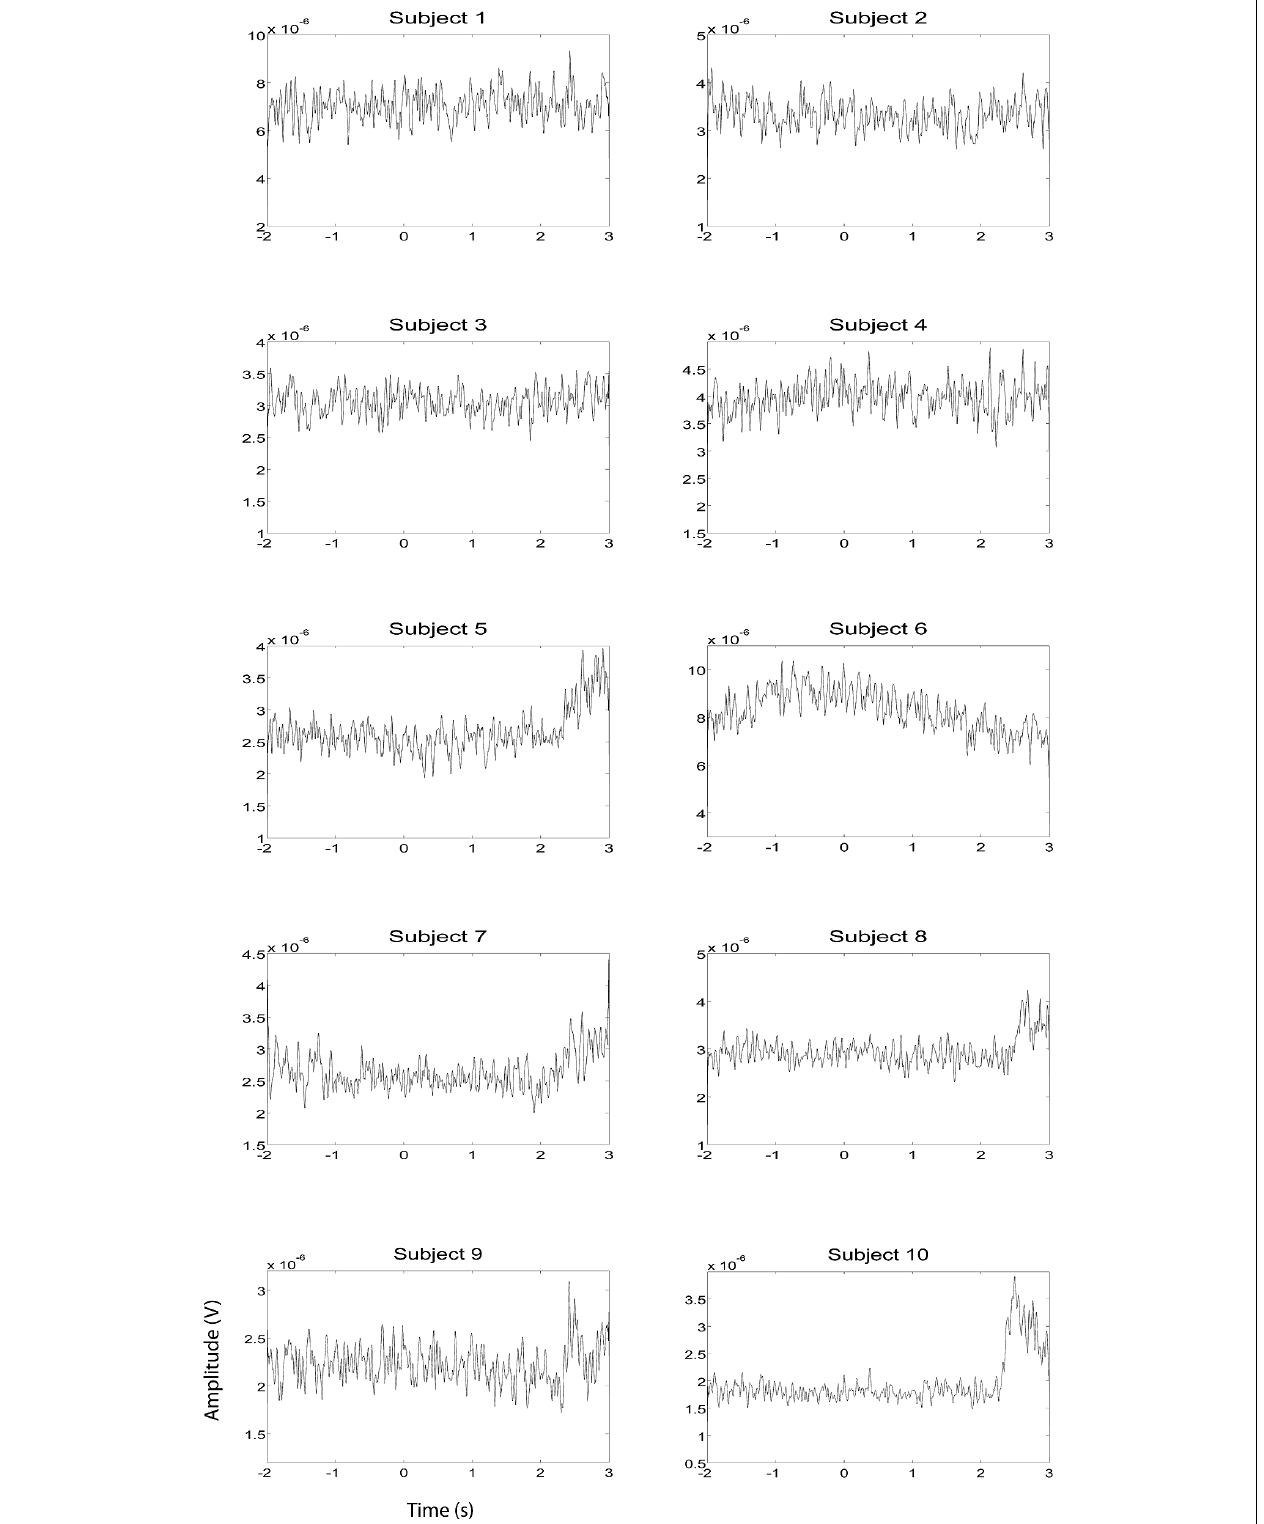
FIGURE 2 | EMG HG magnitude of the left hand during left hand motor imagery EEG recording sessions ( n = 10). EMG activity was averaged over all trials that were not contaminated by artifacts. Units of the EMG are inV.